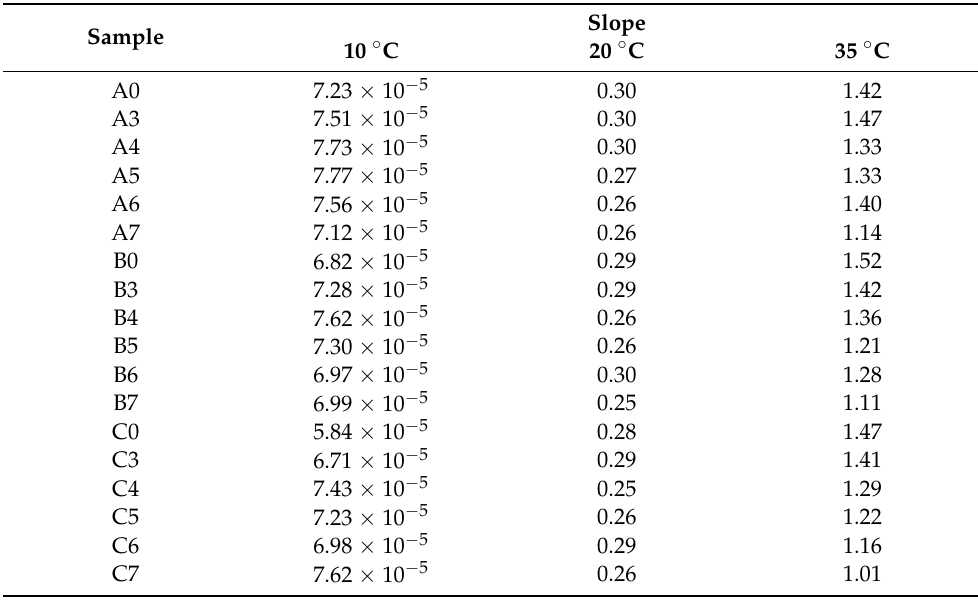
Table 3. Slope of paste heat flow curve in the acceleration period at different temperatures.